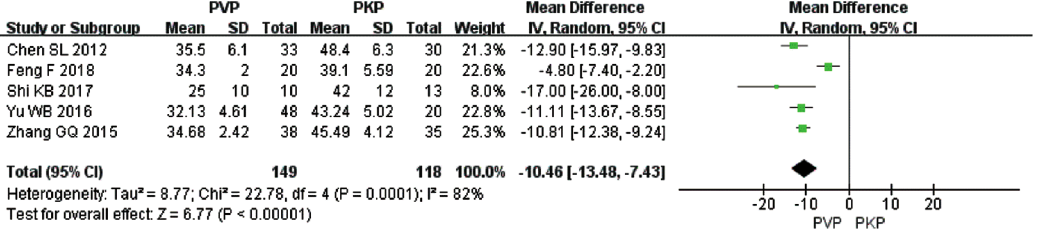
Figure 8. Forest plot to assess the operation time between the two